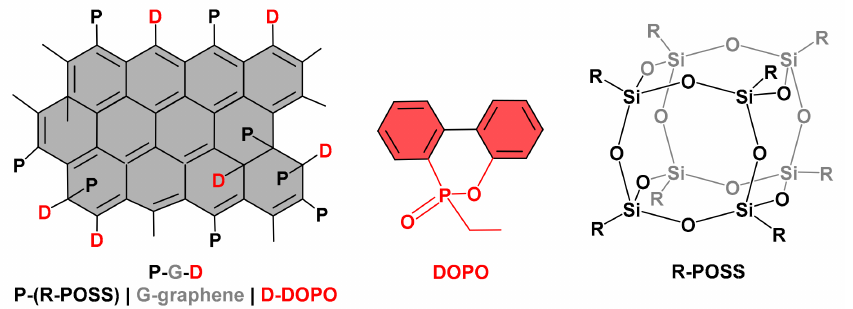
Figure 9. Multi-composite flame retardant, combining oapPOSS, graphene, and DOPO.